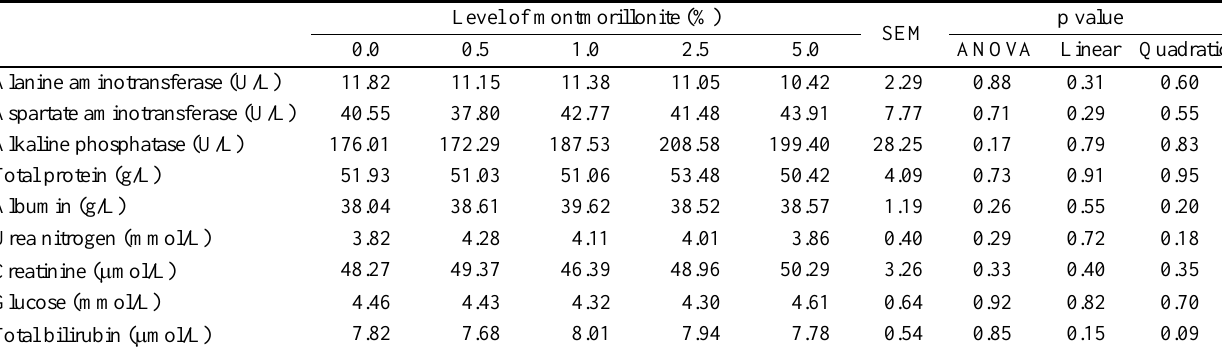
Table 3. Serum biochemical measures of weaned pigs fed diets containing graded levels of montmorillonite (d 28) 1